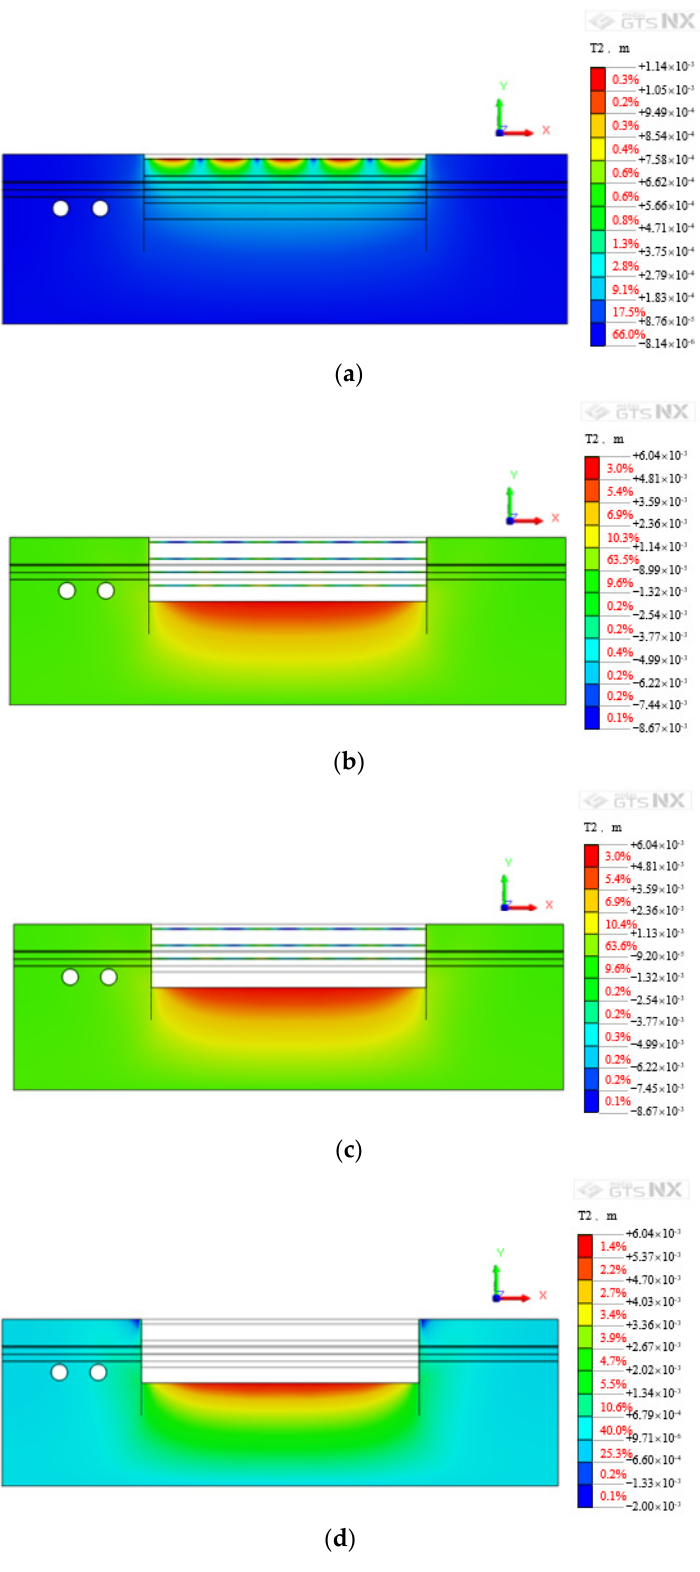
Figure 8. Vertical deformation caused by construction of section A. ( a ) Excavate to − 2.20 m elevation. ( b ) Excavate to the design elevation of the bottom of the foundation pit. ( c ) The inner supports on the fourth layer are removed. ( d ) All inner supports are removed.